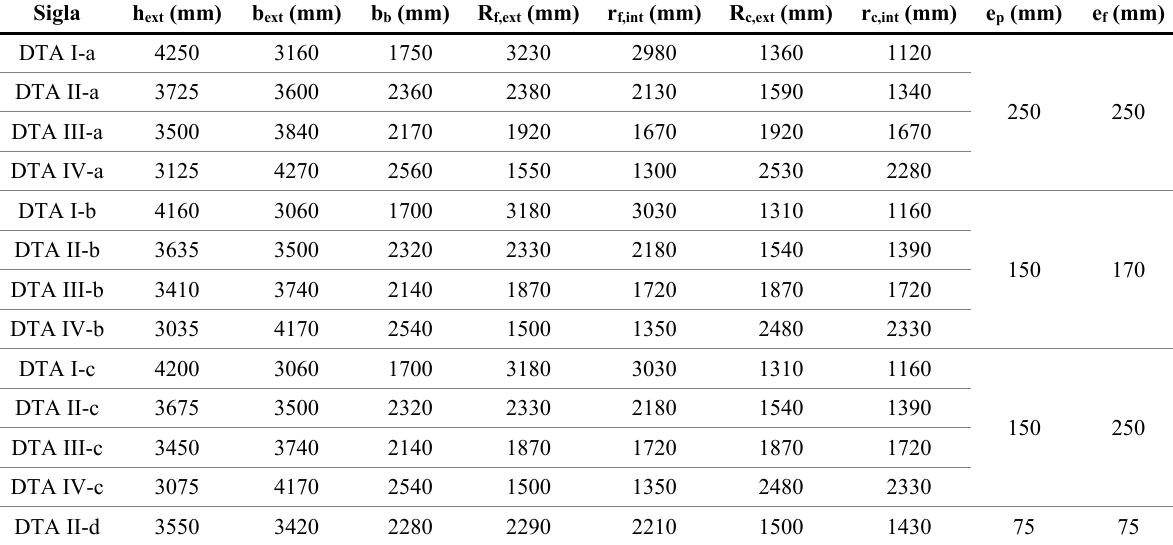
Table 2. Geometric parameters of the culvert defined by three